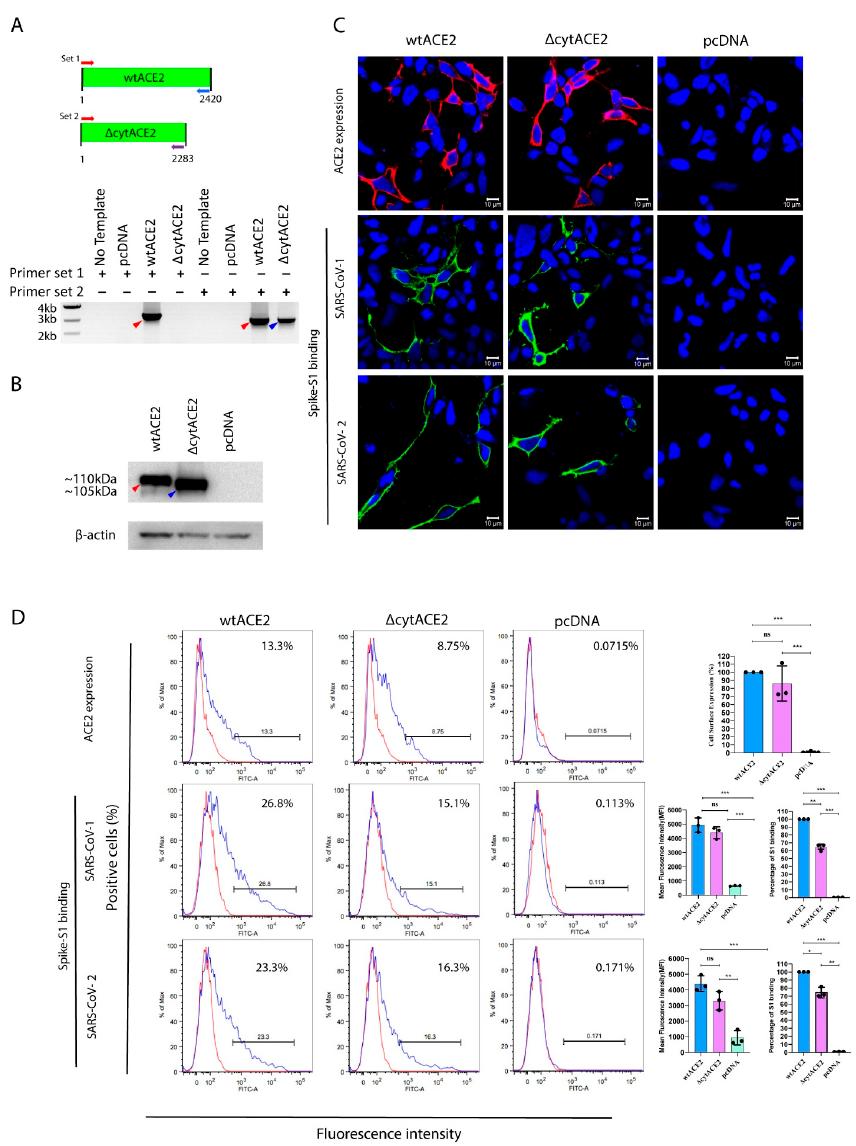
Figure 2. Cell surface expression and binding of SARS-CoV spike S1 proteins on wtACE2 or Δ cytACE2 receptor. Confirmation of expression of wtACE2 and ∆ cytACE2 in HEK293T-transfected cells. ( A ) Total RNA was extracted from the cells transfected with either wtACE2 or Δ cytACE2 and RNA transcripts were analyzed using RT-PCR by specific primer sets. ( B ) Protein expression was confirmed by Western blot analysis of cell lysates. Red arrow indicates wtACE2 and blue indicates ∆ cytACE2 ( C ) Confocal imaging and quantitative flowcytometry analysis of wtACE2 and ∆ cytACE2 surface expression on HEK293T cells and SARS-CoVs S1-Fc binding. Plasmids encoding wtACE2 and ∆ cytACE2 were transiently expressed in HEK293T cells and the ACE2 expressions were detected using anti-ACE2 polyclonal antibody at 24 h post transfection (red, upper panel). Similarly, cells expressing wtACE2 and ∆ cytACE2 were treated with either SARS-CoV-1 or -2 S1-Fc proteins (5 µ g/mL) and stained using goat anti human IgG Fc conjugated with FITC (green, middle, and lower panels). Nuclei were stained with DAPI (blue). ( D ) Cell surface expression of wtACE2 and ∆ cytACE2 on HEK293T cells (upper panel), and S1 binding on wtACE2 and ∆ cytACE2 receptors (middle and lower panels). Quantitative and comparative analysis of wtACE2 and ∆ cytACE2 expression and S1-Fc binding on HEK293T cells (right graph). Data represented as mean fluorescence intensity and the percentage of S1-binding cells. Data are shown as mean ± SD. p value was determined by one-way ANOVA analysis (* p < 0.05; ** p < 0.01; *** p <